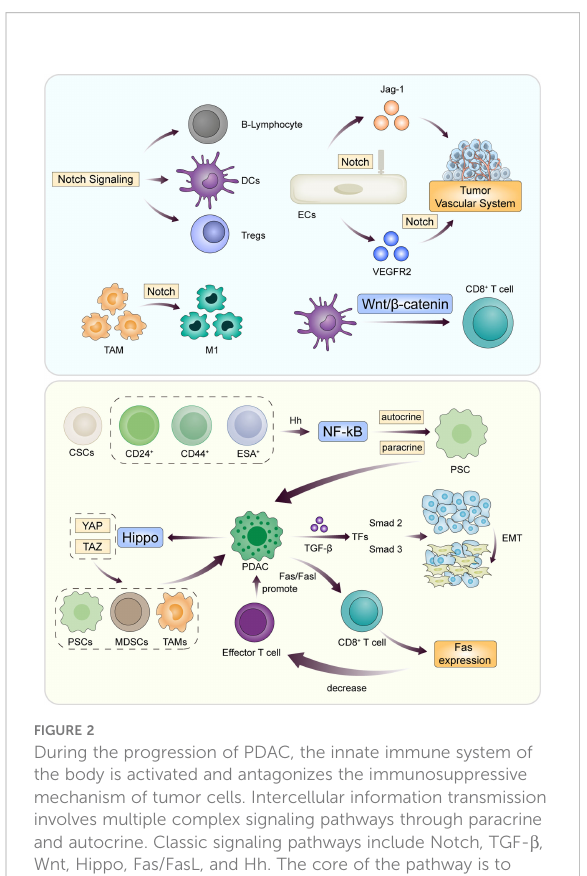
FIGURE 2 During the progression of PDAC, the innate immune system of the body is activated and antagonizes the immunosuppressive mechanism of tumor cells. Intercellular information transmission involves multiple complex signaling pathways through paracrine and autocrine. Classic signaling pathways include Notch, TGF- b , Wnt, Hippo, Fas/FasL, and Hh. The core of the pathway is to promote or inhibit the function of B cells and effector T cells by changing the cellular components of